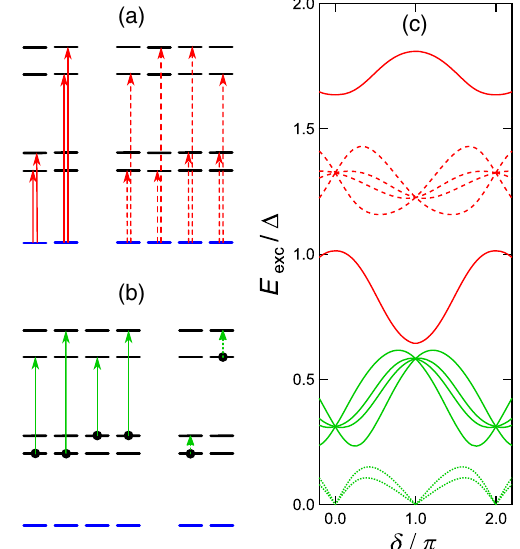
FIG. 2. Possible parity-conservingtransitions in a weak linkwith spin-split ABS [level positions correspond to the phase difference indicated with an arrow in Fig. 1(e)]. Blue line corresponds to the groundstate.(a)Pairtransitions.A pair ofquasiparticles arecreated from the ground state, either both in the same manifold (solid arrows) or not (dashed arrows). (b) Single-particle transitions. A quasiparticle already present in one ABS (solid dot) is excited to another ABS, either in the same (dotted arrows) or in another (solid arrows) manifold. (c) Corresponding transition energies as a function of the phase difference δ across theweak link. (Transitions involving quasiparticles in the continuum are not represented).